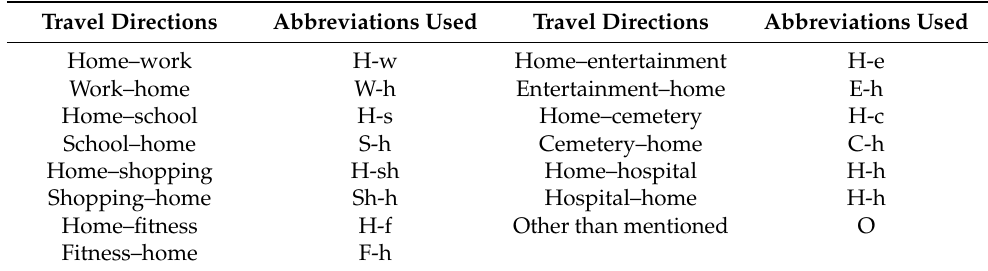
Table 3. Travel directions suggested to the respondents and the abbreviations used in their analysis. Travel